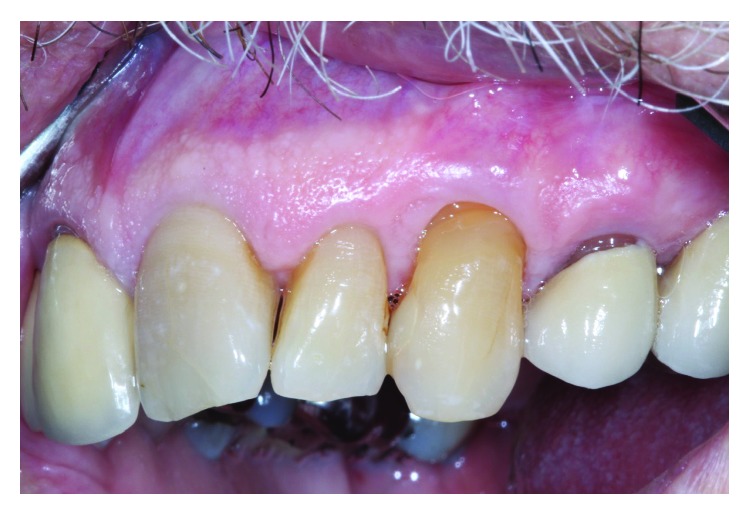
18-month follow-up.